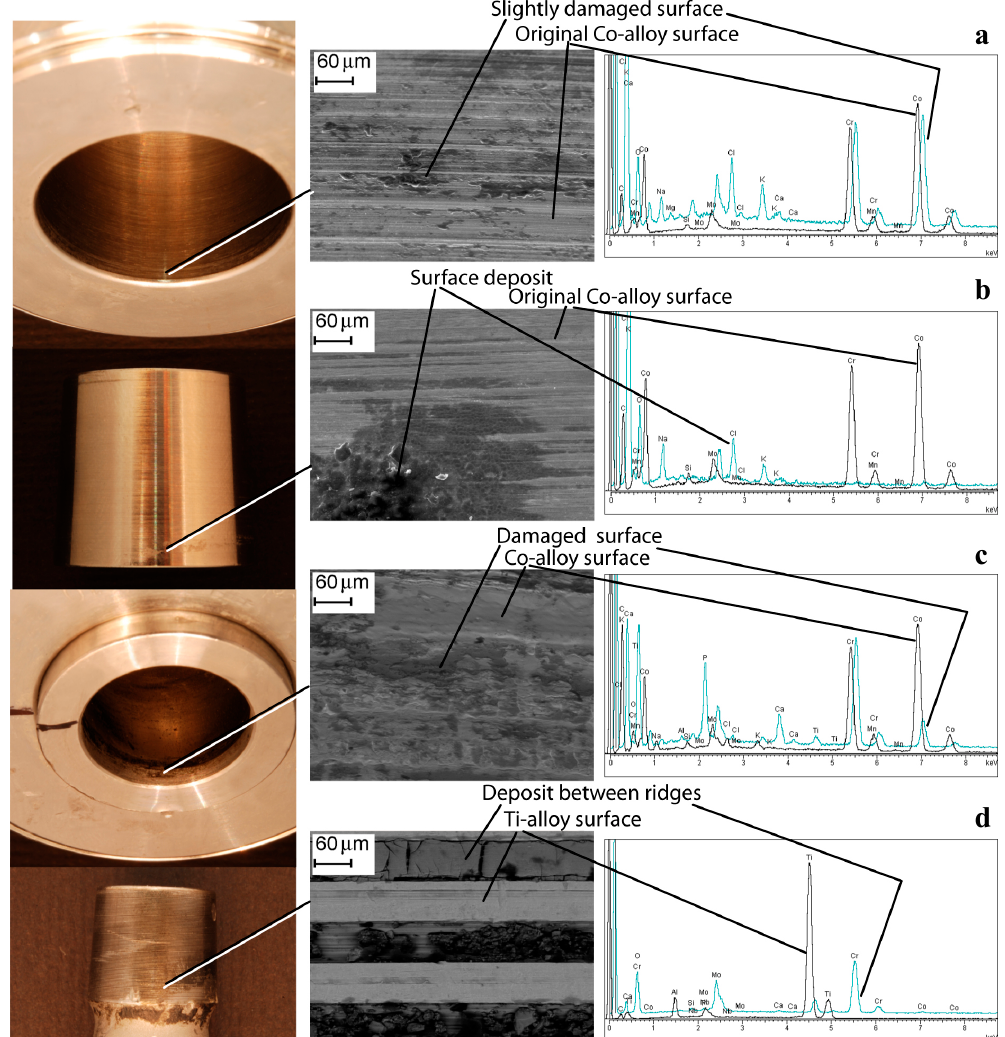
Figure 6. The bore of a Co-alloy head, its adapter sleeve (Co-alloy), and its male taper made of Ti-alloy. Damaged areas are visible in the 12/14 junction. The head-adapter sleeve junction is very slightly damaged. EDX spectra of Co-alloy and slightly damaged area on the head bore ( a ); Co-alloy and deposits on the sleeve male taper ( b ); Co-alloy and damaged area on the sleeve bore ( c ); and Ti-alloy and deposits between the ridges on the male taper ( d ) are shown. Table 5. Ion concentration in serum determined for each group. Sample size N is reported for each